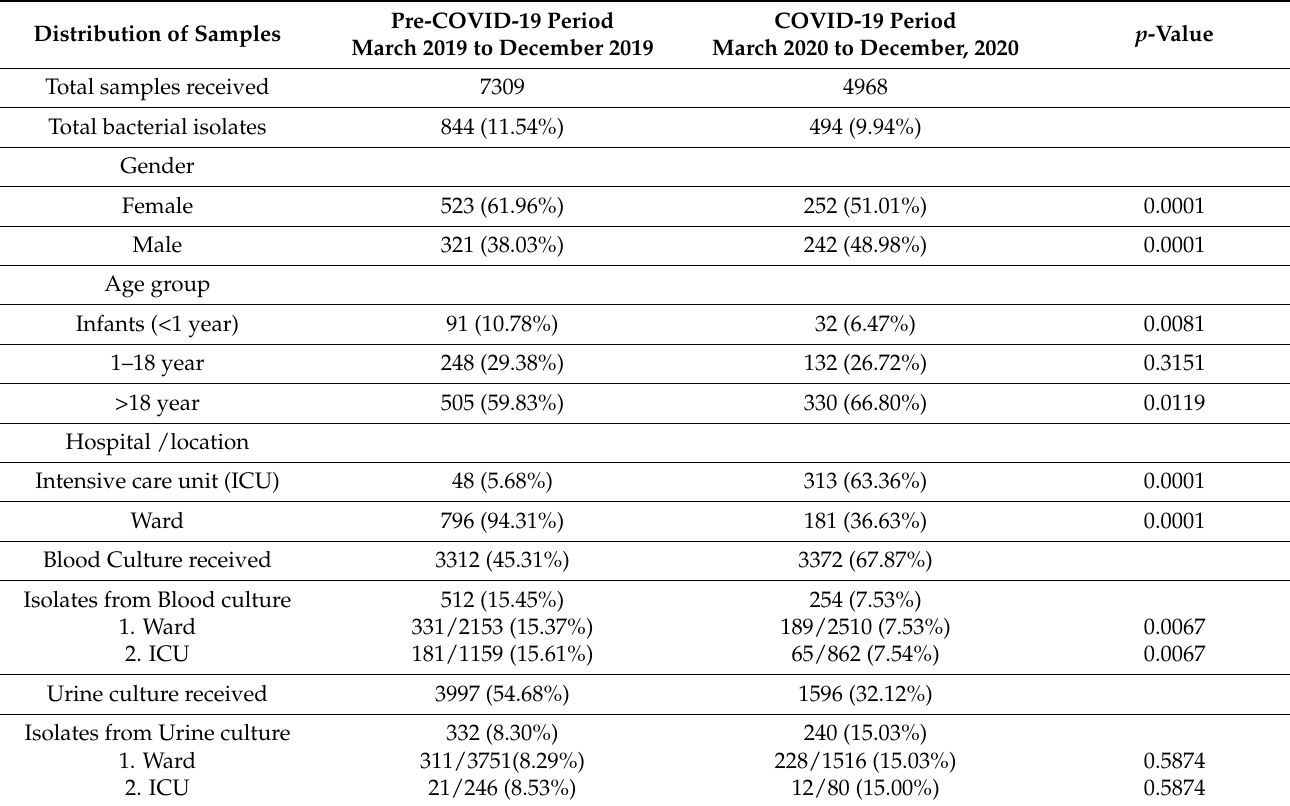
Table 1. Distribution of samples (Blood and Urine) during pre-COVID-19 and COVID-19 period. Pre-COVID-19 Distribution of Samples